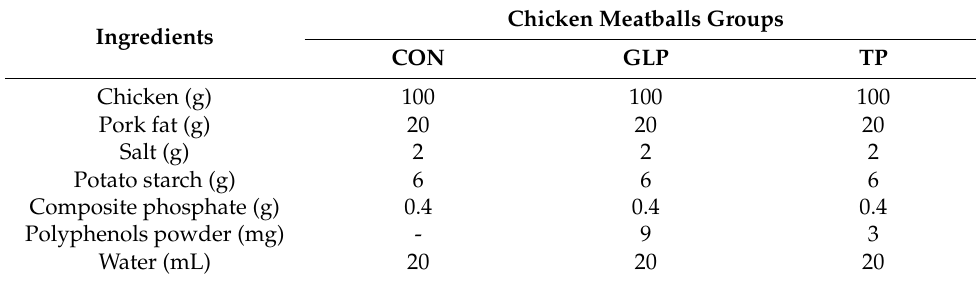
Table 1. The formulations of chicken